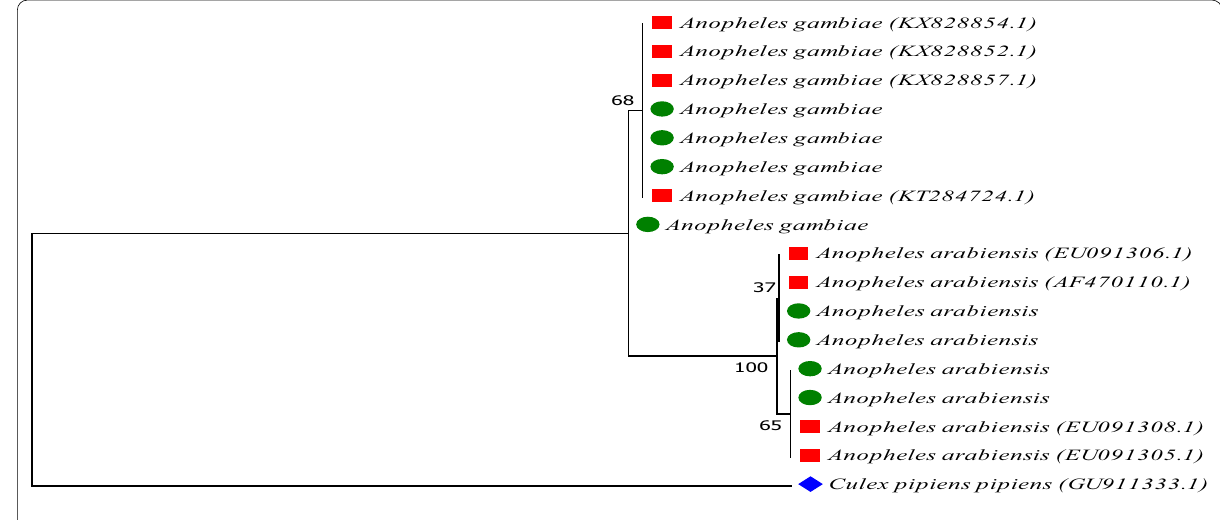
Fig. 3 Molecular phylogenetic analysis of the intergenic spacer ( IGS ) region of Anopheles spp. by Maximum Likelihood method inferred by Tamura‑Nei method after 1000 replications. Culex pipiens pipiens was used as an outlier